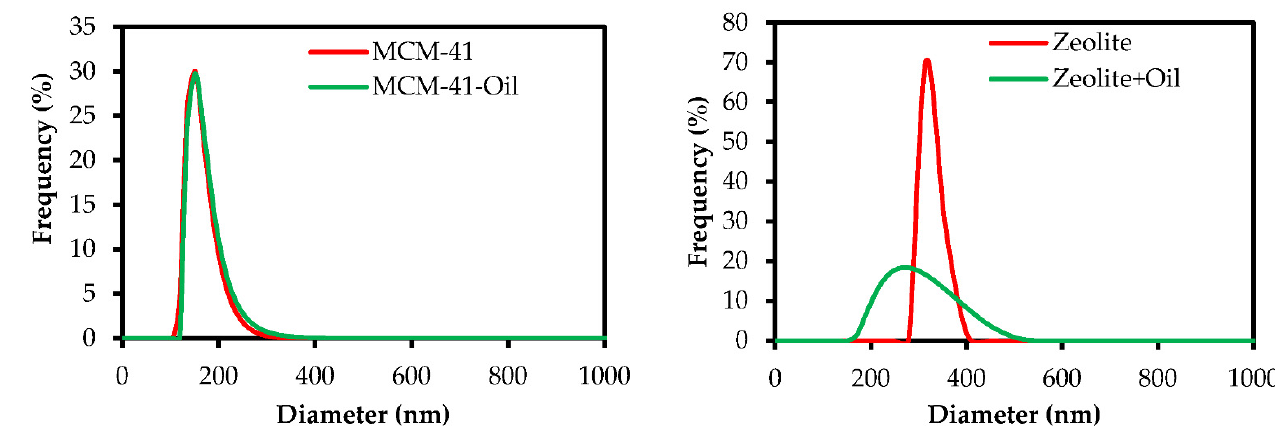
Figure 4. Dynamic light scattering (DLS) of MCM-41, MCM-41-essential oil, zeolite 3A, and zeolite 3A essential oil.